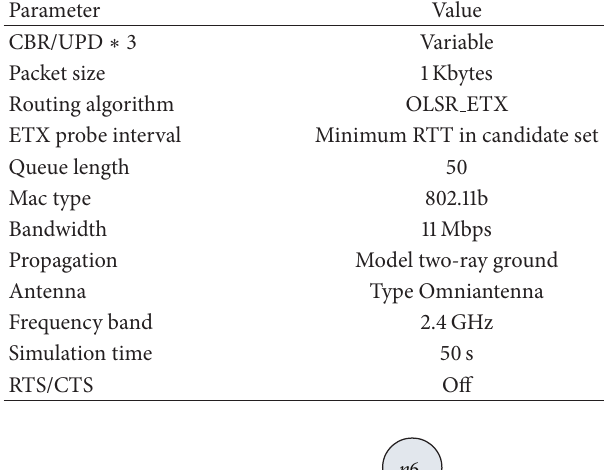
Table 1: Parameter setting.